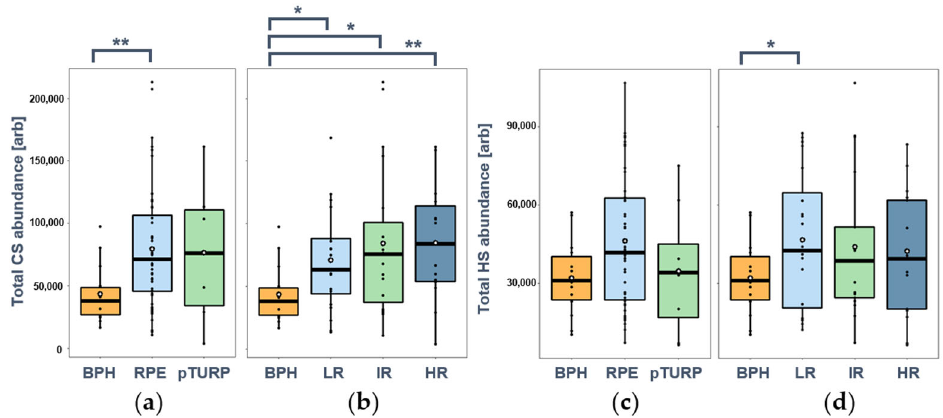
Figure 3. Total abundances of CS and HS chains in BPH and prostate cancer (PCa) tissues: ( a ) CS abundance in BPH and PCa tissues obtained via radical prostatectomy (RPE, n = 48) and palliative transurethral resection (pTURP, n = 6); ( b ) CS abundance in BPH and PCa tissues from low-risk (LR, n = 21), intermediate-risk (IR, n = 19), and high-risk (HR, n = 14) patients based on Gleason risk stratification; ( c ) HS abundance in BPH and PCa tissues obtained via RPE ( n = 46) and pTURP ( n = 8); ( d ) HS abundance in BPH and PCa tissues from LR ( n = 20), IR ( n = 17), and HR ( n = 17) patients based on Gleason risk stratification. (*: p < 0.05, **: p < 0.01).